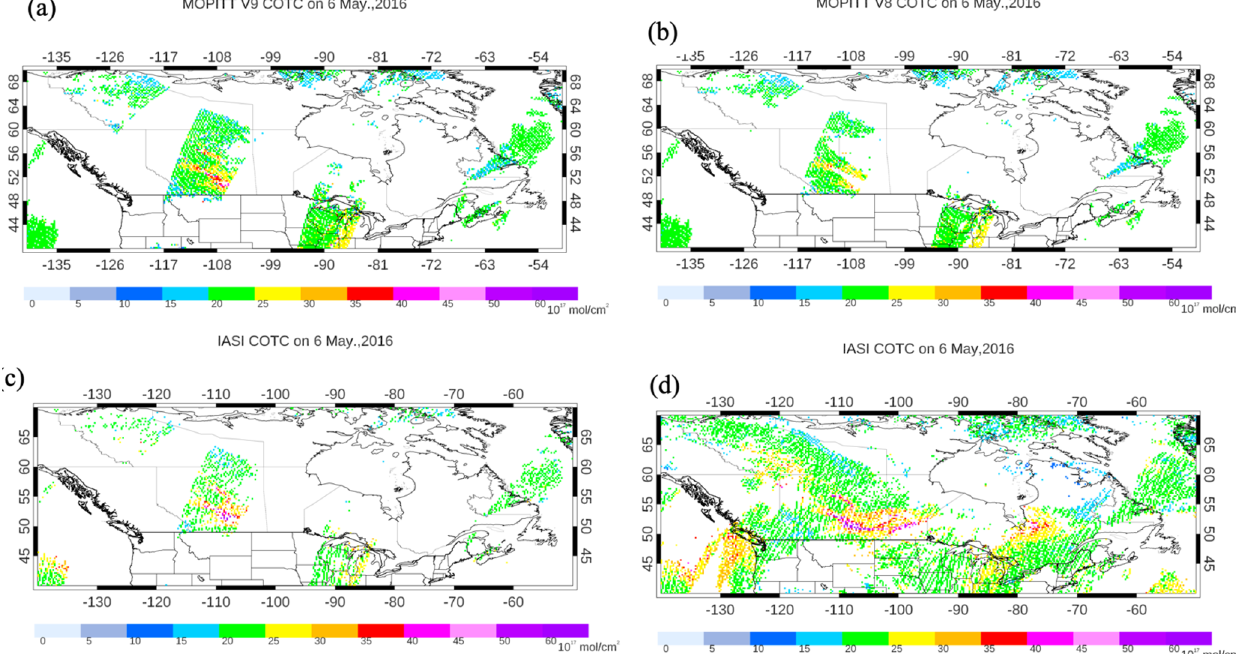
Figure 10. MOPITT CO total column for V9 (a) and V8 (b) . IASI CO total column observations of the corresponding with MOPITT (c) and the entire IASI CO retrievals (d) on 6 May